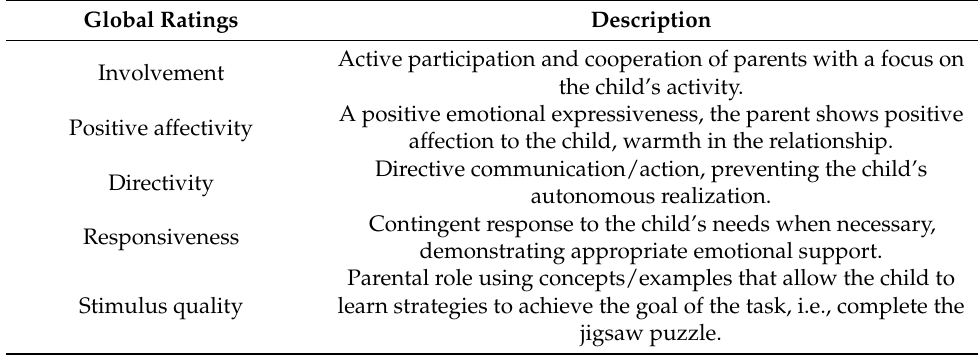
Table 2. The dimensions used in the global